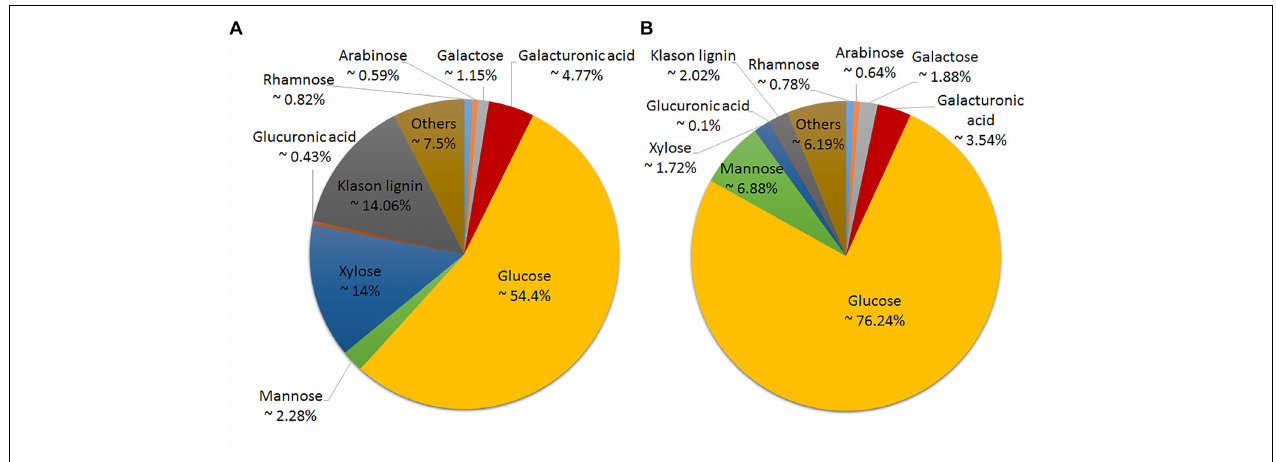
FIGURE 2 | Cell wall composition of hemp stem (A) and hemp bast fiber (B) as an average of the six hemp accession analyzed.